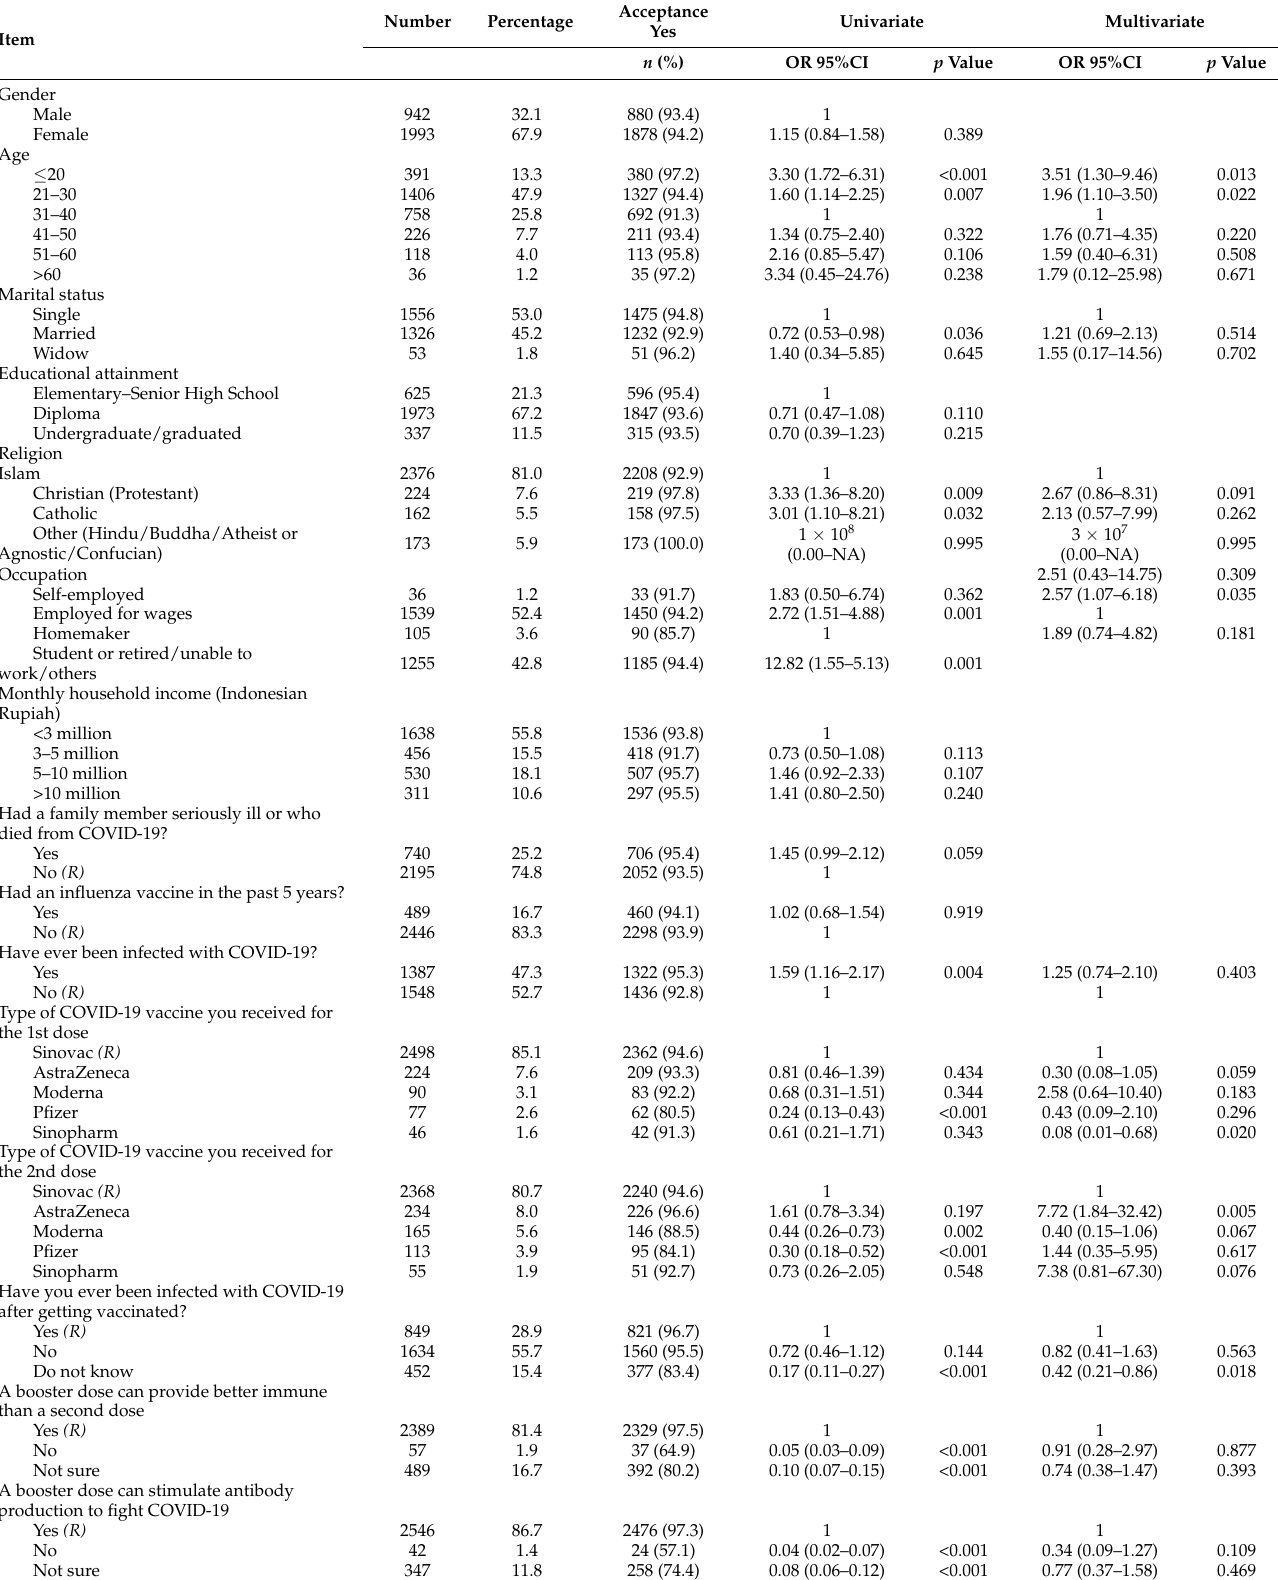
Table 4. Initial multivariable linear regression model showing the factors associated with acceptance for a booster dose of the COVID-19 vaccine in Indonesia ( n =